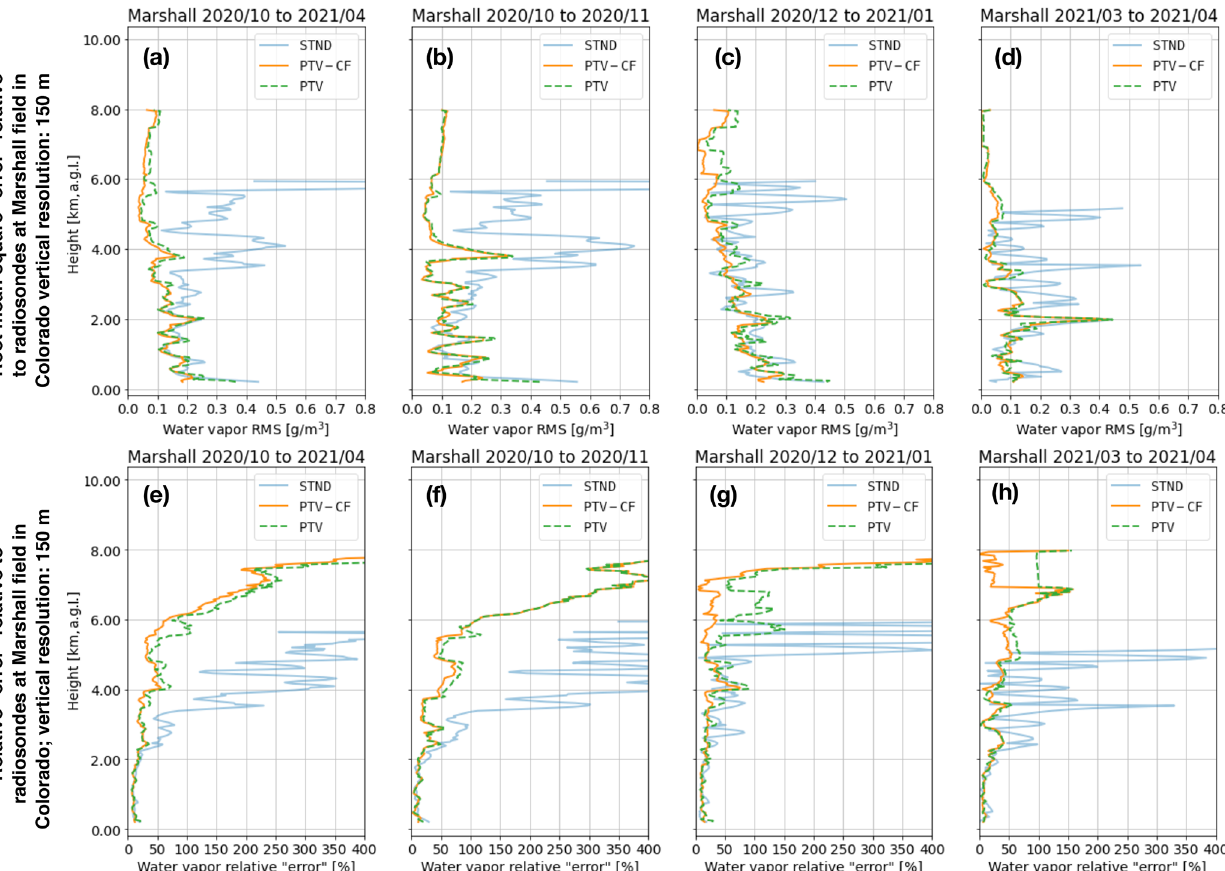
Figure 7. For the all the Marshall datasets, (a) shows the root-mean-square “error” (RMSE) relative to the radiosonde (RS) water vapor (WV) measurements for the standard method ( STND ) and the PTV-MPD method with ( PTV-CF ) and without ( PTV ) the coarse-to-fine configuration, and (e) shows the corresponding relative RMSE. Panels (b) to (d) show the RMSE for each individual Marshall dataset, and (f) to (h) show the corresponding relative RMSE. Note that the scale of the horizontal axes in (a) to (d) are smaller than those shown in Fig.